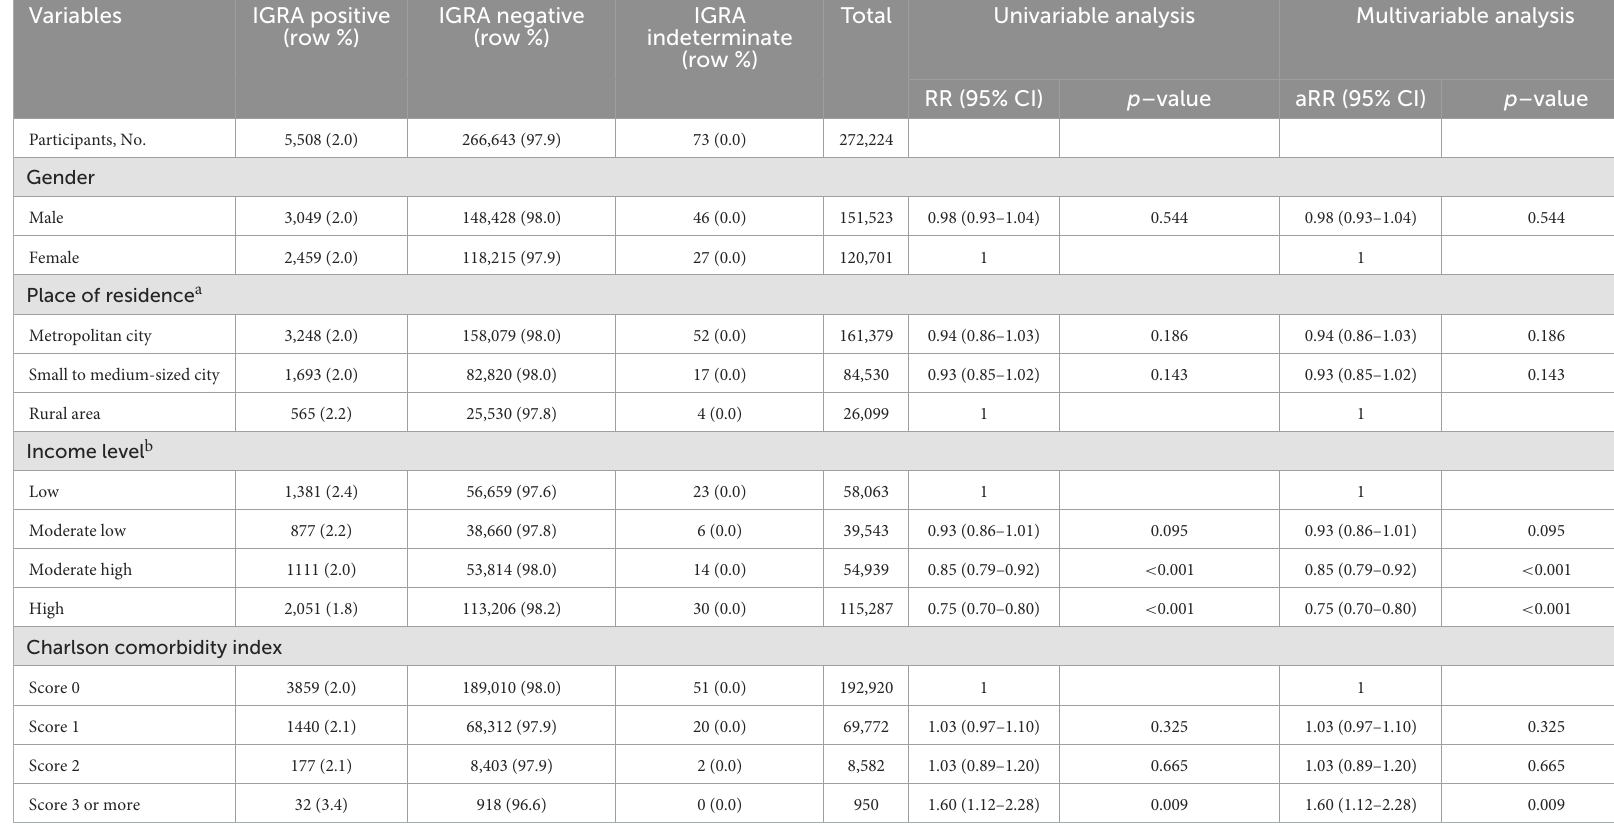
TABLE 3 Prevalence of LTBI in Group B (first year students in high school and out-of-school youths) and risk factors for LTBI.